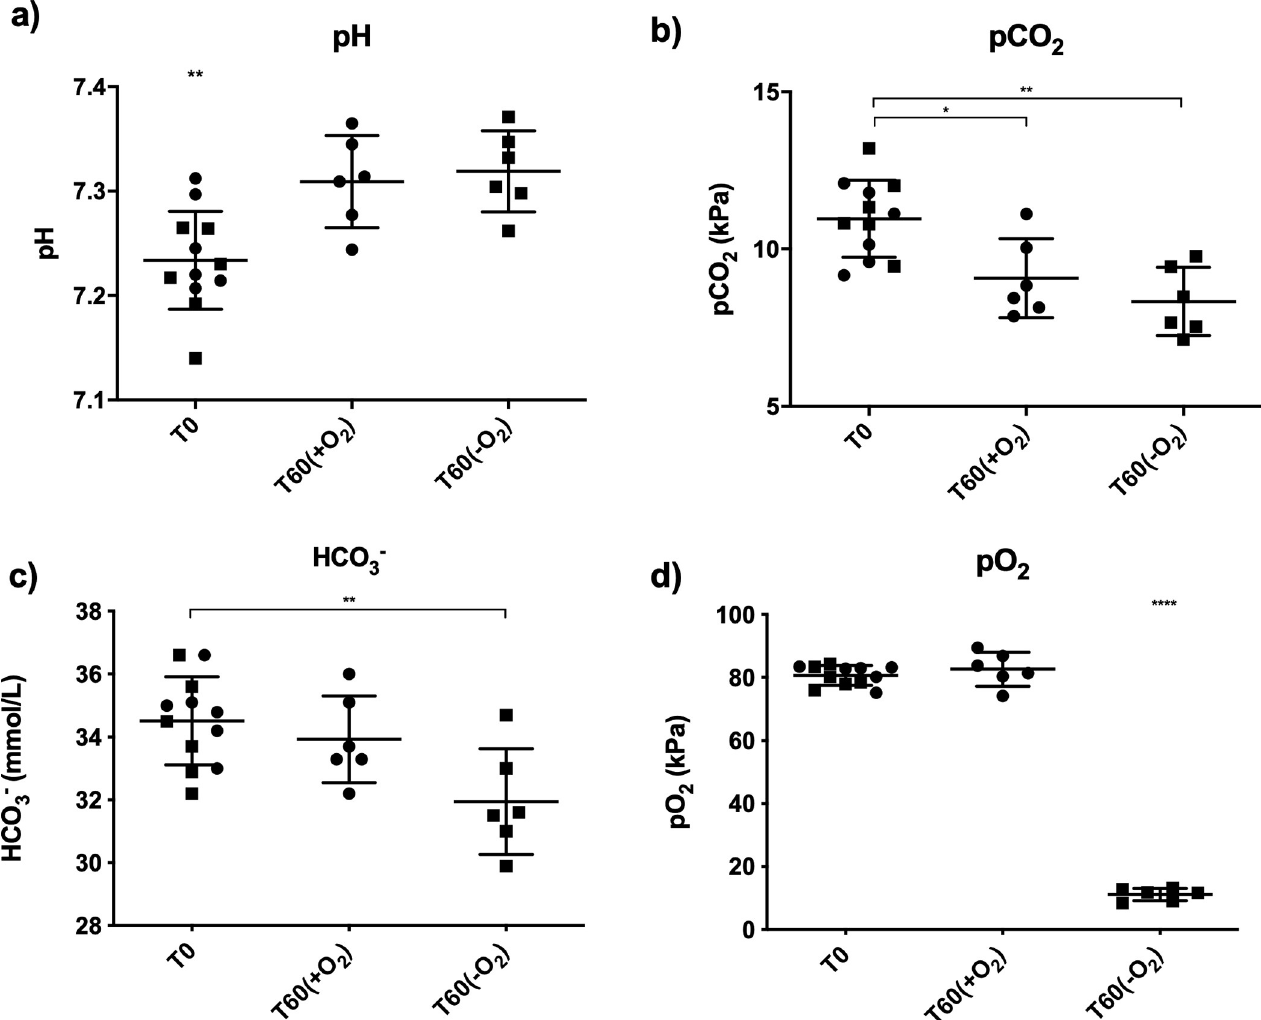
Fig 2. Blood acid-base status with pH (a), pCO 2 (b), HCO 3- (c) and pO 2 (d) of rats after surgery under fentanyl/fluanisone and midazolam anaesthesia. T0 represents measurements immediately after surgery. Measurements 60 minutes (T60) after surgery are indicated by +O 2 (with oxygen supply) and -O 2 (without oxygen supply). Symbol shape indicates +O 2 group for circle and -O 2 group for square. In (a) �� indicates p < 0.01 for T0 versus T60(+O 2 and -O 2 ). In (b) � indicates p < 0.05 for T0 versus T60(+O 2 ) and �� p < 0.01 for T0 versus T60(-O 2 ). In (c) �� indicates p < 0.01 for T0 versus T60(-O 2 ) and in (d) ���� indicates p < 0.0001 for T60(-O 2 ) versus T0 and T60(+O 2 ). Values are means ± standard deviations.